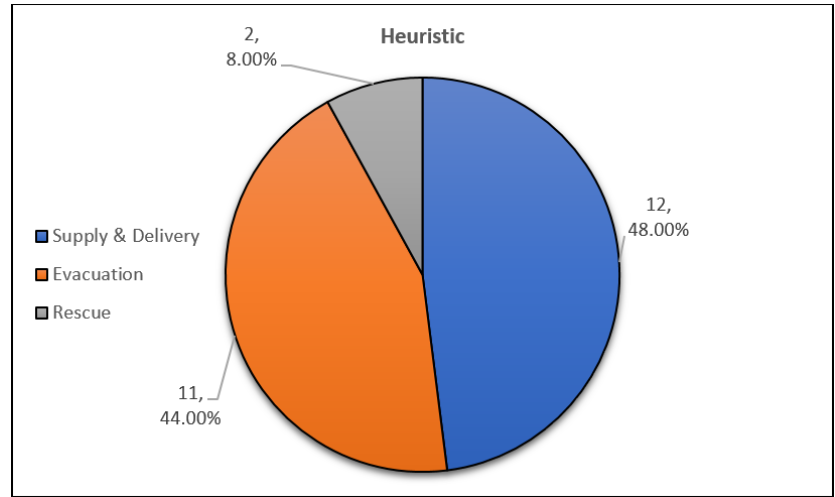
Figure 29. Selected Humanitarian Operation based on Heuristic Solution.